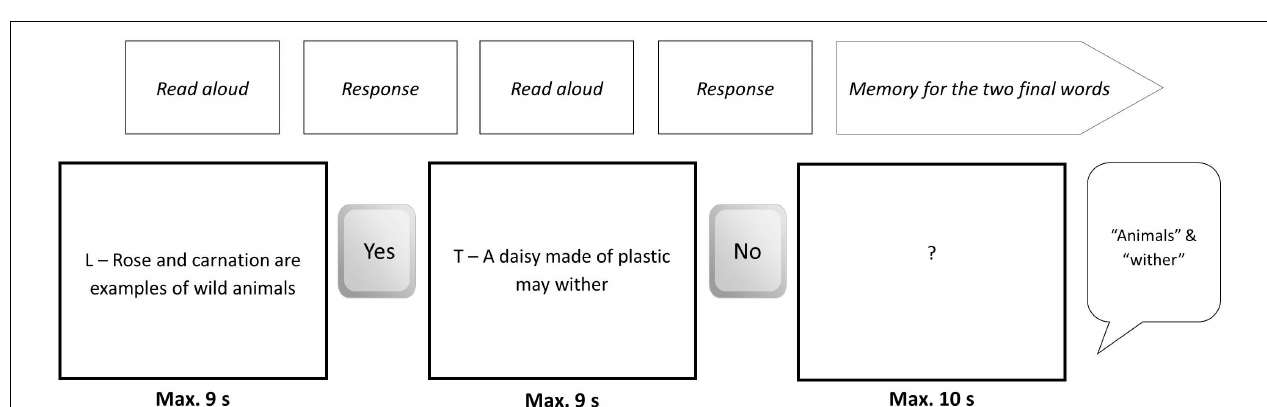
FIGURE 1 | Schematic representation of the experimental procedure.